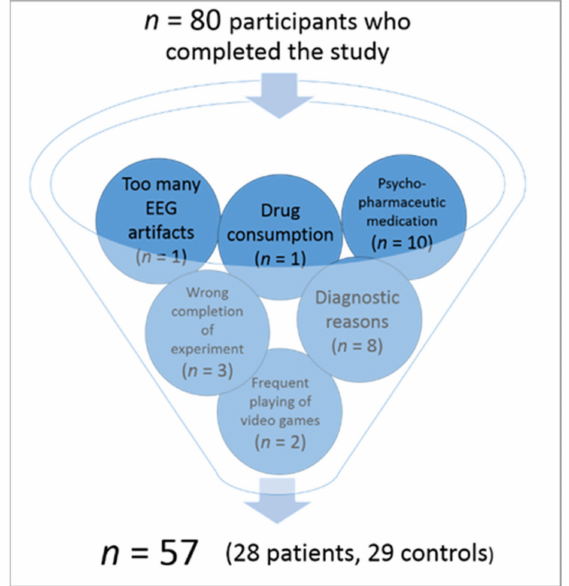
Figure 1. Exclusion process for selecting the EEG subjects starting with the total study sample ( n = 80). As some participants fulfilled more than one of the exclusion criteria, the indicated n in the brackets is larger than the number of excluded participants ( n =